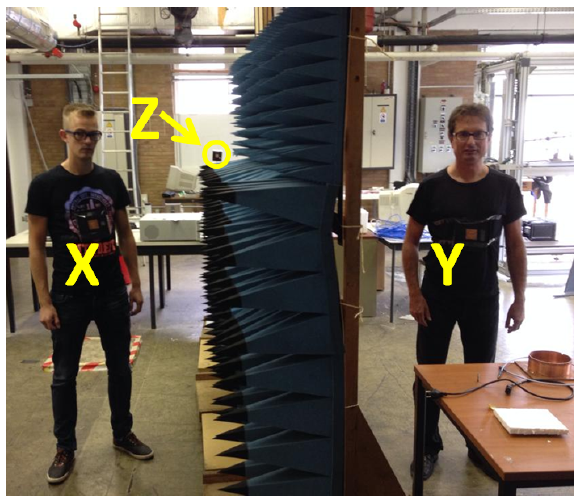
Figure 4. Indoor measurement area, Alice-Bob Non Line of Sight, Eve Line of Sight to both legitimate parties, Scenario 7. Letters indicate indoor